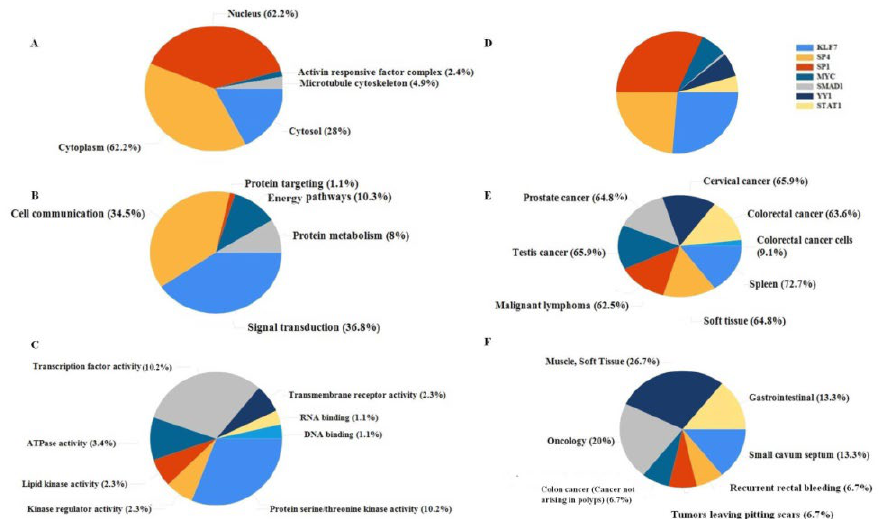
Figure 6. Functional enrichment of miR-122 interactors. ( A ) Subcellular localization of the interactors; ( B ) Involvement of interactors in the different biological process; ( C ) Interactor involvement in molecular function; ( D ) Transcription factor; ( E ) Site of expression; ( F ) Clinical phenotype.